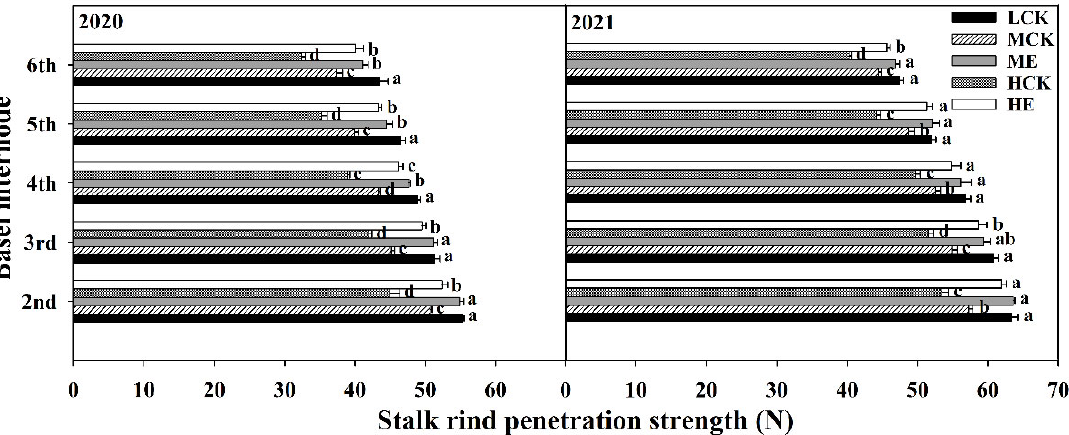
Figure 5. Effects of spraying ethephon on stalk rind penetration strength of summer maize. LCK, MCK, ME, HCK and HE were the treatments of low density control, medium density control, medium density sprayed with ethephon, high density control and high density sprayed with ethephon, respectively. Different lowercase letters in the figure indicated significant difference at 5% level.